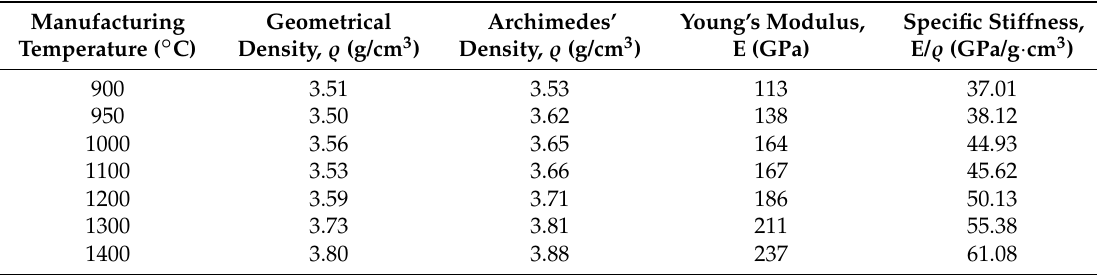
Table 1. Geometrical and Archimedes’ density, Young’s modulus, and specific stiffness of specimens manufactured at different iHP temperatures (from 900 to 1400 ◦